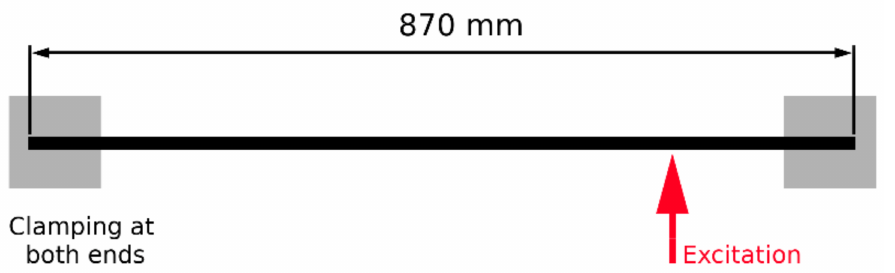
Figure 2. Schematic of the analyzed beam